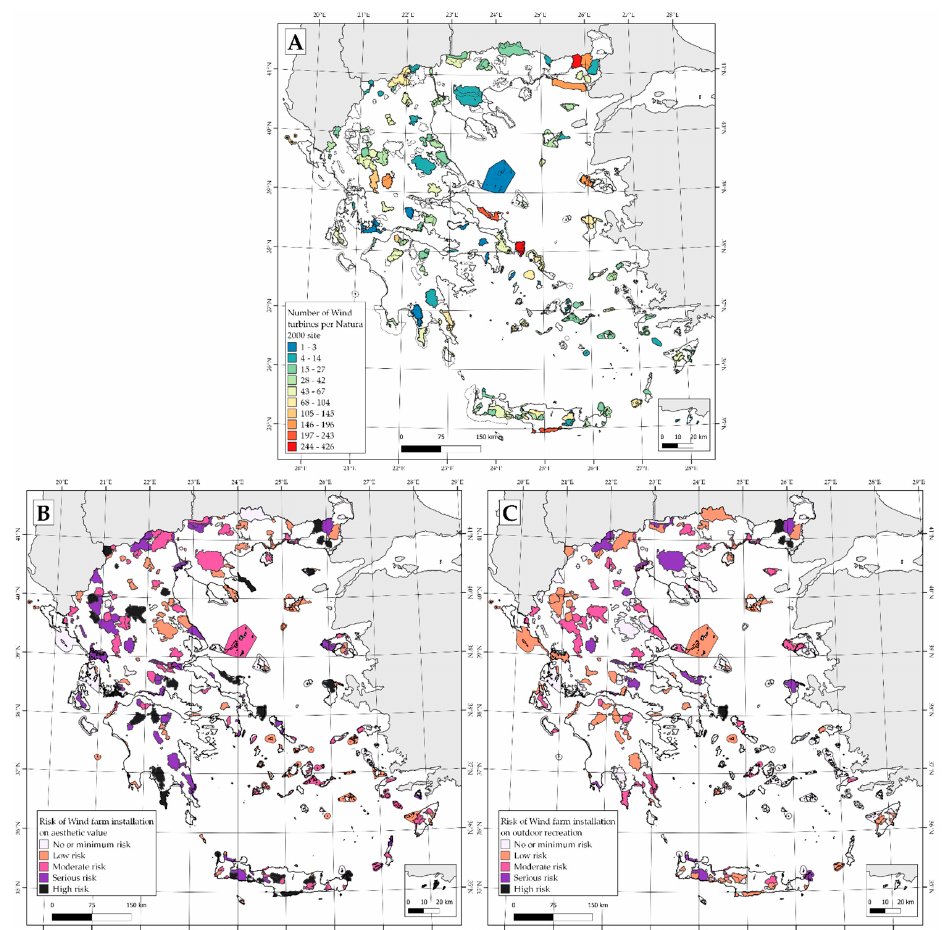
Figure 6. Wind farm risk analysis in Natura sites: total wind farms per site, both operating and proposed ( A ). Potential impact risk map on aesthetic values ( B ) and on outdoor recreation values ( C ). The five-point risk scale follows a simple numerical classification technique (see methods section). Marine-only Natura sites are excluded.